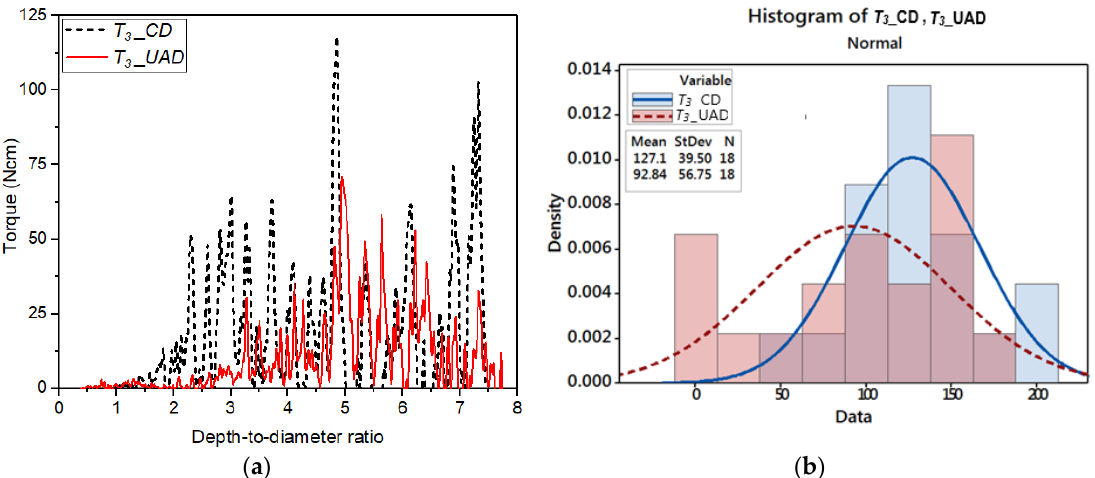
Figure 5. ( a ) A couple of conventional drilling (CD) and ultrasonic assisted drilling (UAD) stick-slip torques and ( b ) probability of the maximum values of stick-slip torques. 248 Table 7. Estimation for Paired